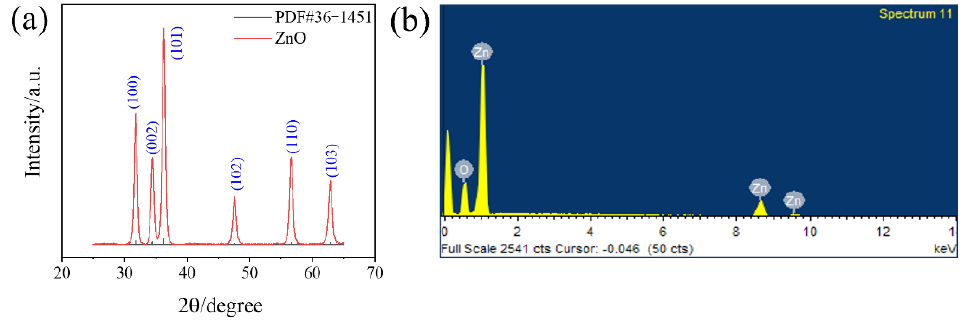
Figure 4. The characterizations of ZnO nanoparticles ( a ) XRD ( b ) EDS.